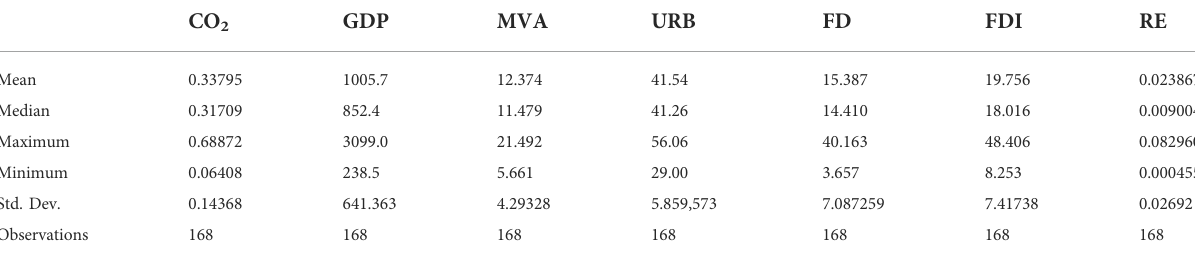
TABLE 2 Descriptive Statistics of selected